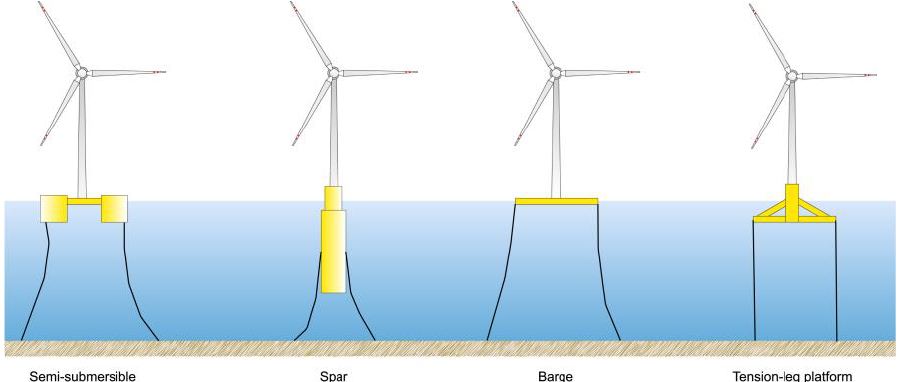
Figure 9. The supporting platforms of FOWTs [86]. Reproduced with permission from Micallef et al., Renewable and Sustainable Energy Reviews; published by Elsevier, 2021.